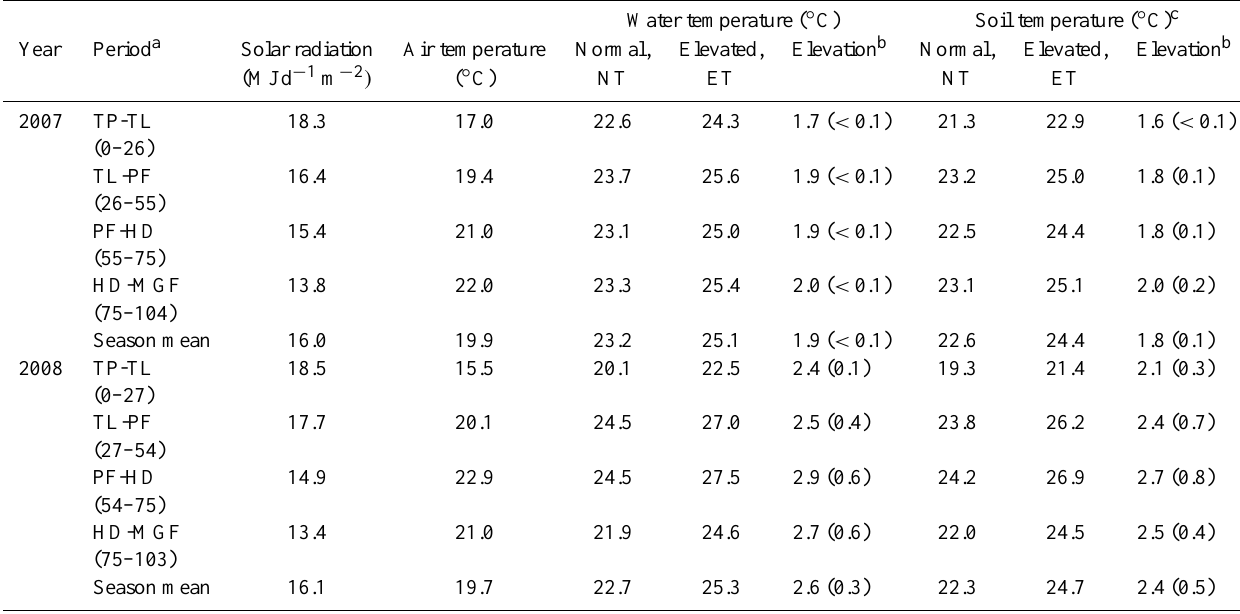
Table 1. Solar radiation and mean temperature of air, water, and soil (averaged over 6 fields) for each sampling period and the two cropping seasons (2007 and